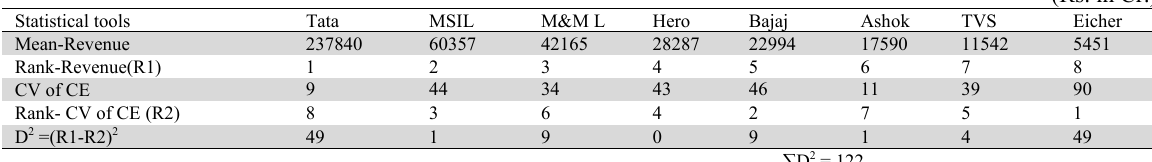
Relationship between revenue and growth variability of capital employed of leading Indian automobile sector